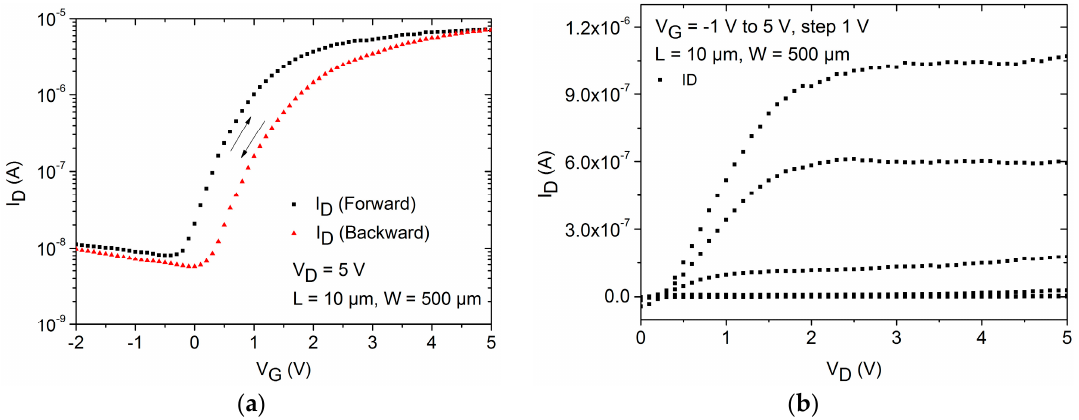
Figure 3. ( a ) Transfer and ( b ) output characteristics of a ZnO nanoparticle TFT applying an inverted coplanar setup.